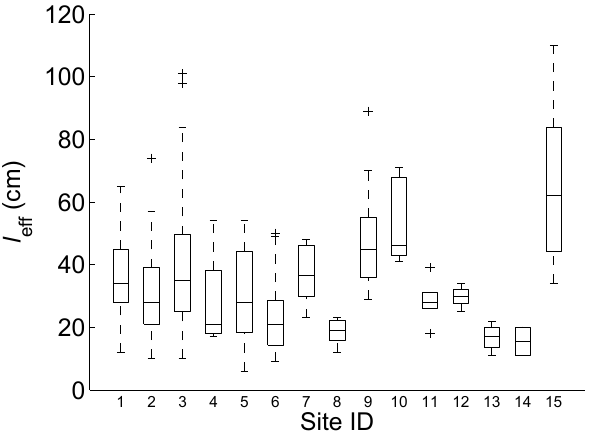
Fig. 6. Box plot of effective correlation lengths ( s eff ) per site ac- cording to the index shown in Table 1. Fig. 7. Dependence of l eff on the backscatter observations ( σ 0 ) for different intervals of incidence angle ( θ ).